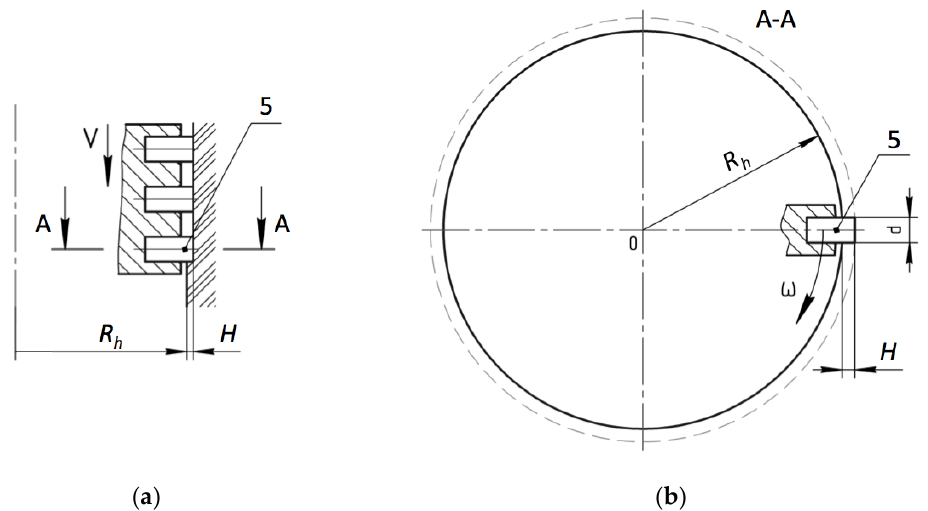
Figure 10. Partial area of the blade with calibrating insert: ( a ) Intersection along the axis; ( b ) Intersection A-A.